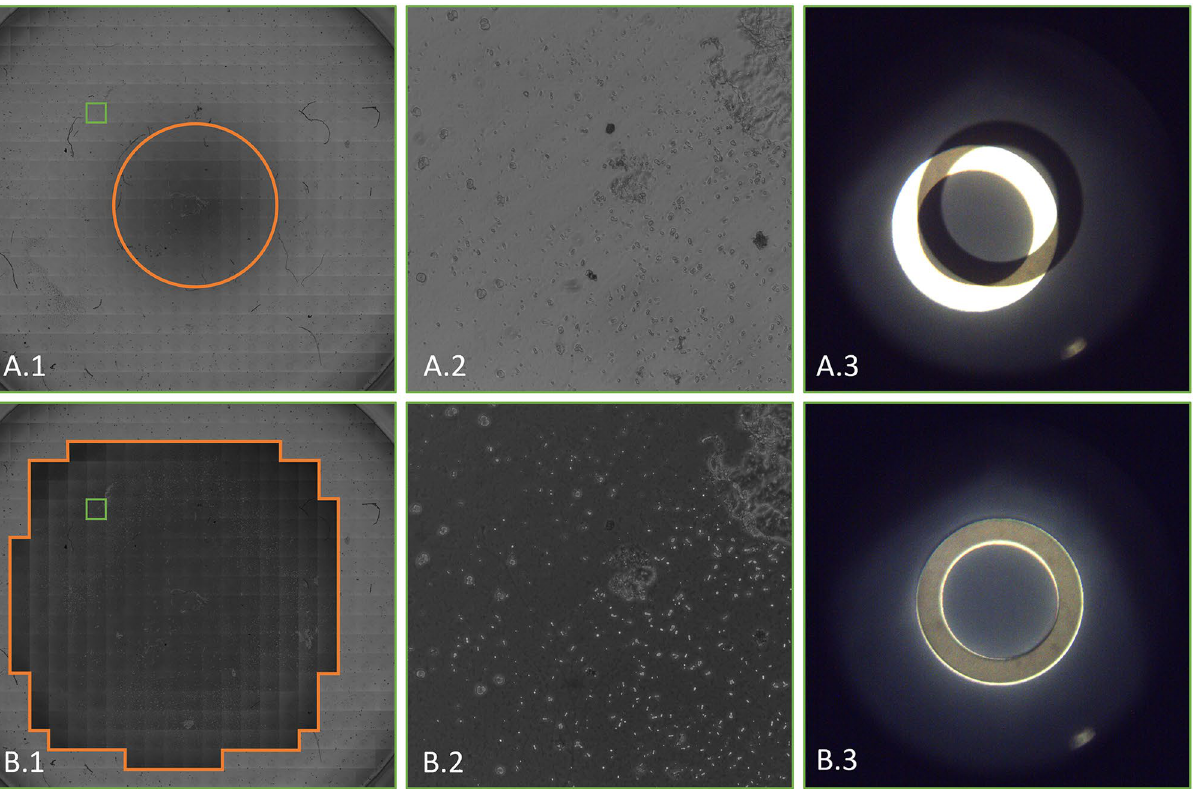
Figure 6. Comparison of standard ( A.1 – A.3 ) and adaptive ( B.1 – B.3 ) phase contrast microscopy images of one well in a 24-well MTP, 10x magnification. ( A.1/B.1 ) Stitched images of the whole well. Phase contrast conditions are present in areas with a dark background. For clarification, they are outlined in orange. The images highlighted with a green box are shown in ( A.2/B.2 ), respectively. ( A.2 ) No phase contrast conditions are established. ( A.3 ) The phase ring and condenser annulus do not align at the position of the image in ( A.2 ). ( B.2 ) Phase contrast conditions apply to the whole image. ( B.3 ) The phase ring and condenser annulus do align at the position of the image in ( B.2